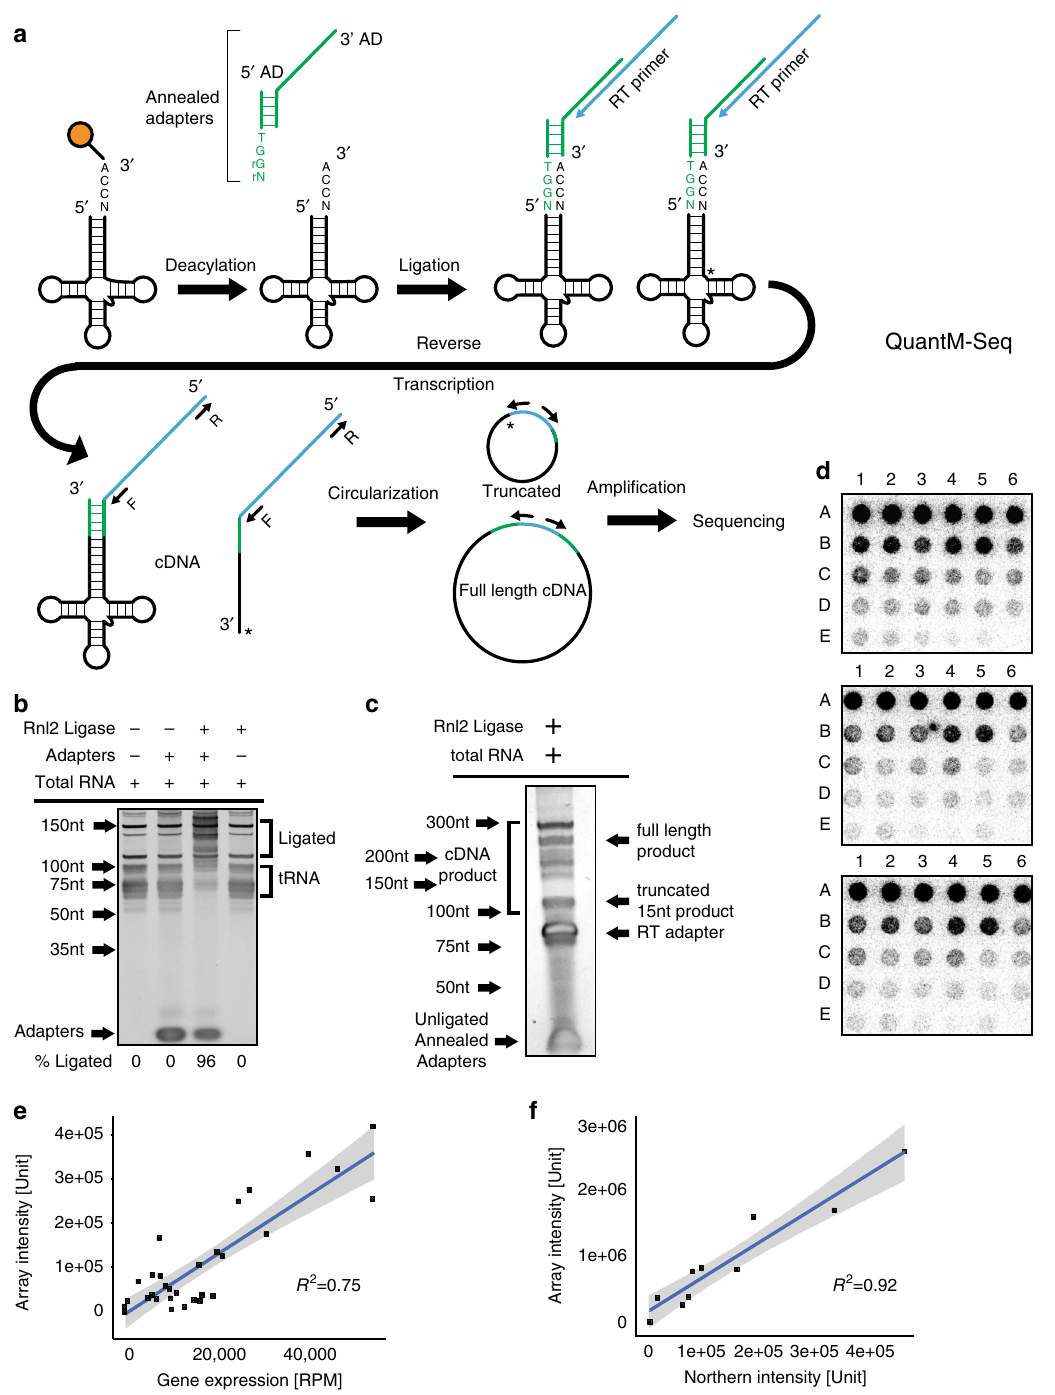
Fig. 1 Quantitative mature tRNA sequencing (QuantM-seq). a Outline of QuantM-seq. tRNA depictions are in black, adapter depictions are in green, and sequences corresponding the RT primer are depicted in blue. The rG and rN at the end of the 5 ′ AD indicate ribonucleotides. b Polyacrylamide gel showing products and ef fi ciency of adapter ligation onto tRNA. Rnl2: T4 RNA Ligase 2. Asterisk (*) indicates 5S and 5.8S ribosomal RNA bands. c Polyacrylamide gel showing products of reverse transcription (cDNA). Rnl2: T4 RNA Ligase 2. d Images of tRNA arrays; each array represents an independent replicate. For the probes spotted at each position see Source Data. e Scatter plot of reads per million derived from QuantM-seq versus array intensities derived from densitometry with a fi tted linear trendline. Shaded area represents the 95% con fi dence interval of the linear trendline. f Scatter plot of northern blot versus array intensities derived from densitometry with a fi tted linear trendline. Shaded area represents the 95% con fi dence interval of the linear trendline. Source data are provided as a Source Data fi le for ( b – f